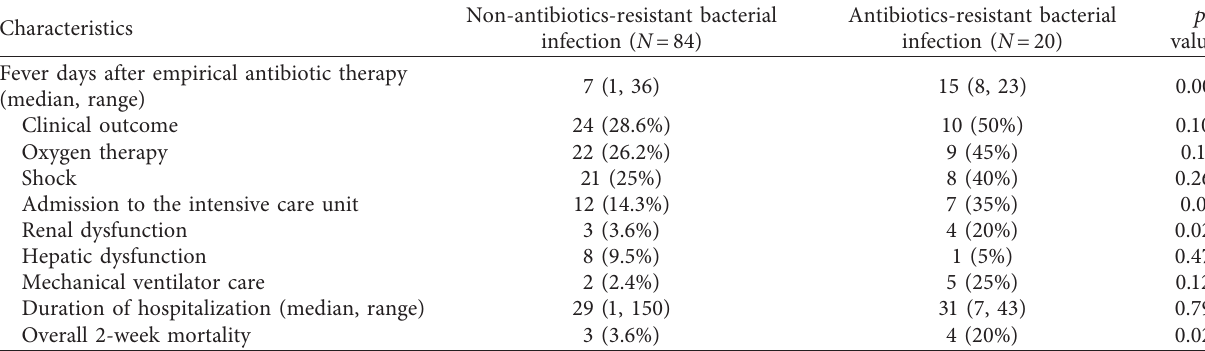
Table 7: Therapeutic response in febrile neutropenic children with Gram-negative bacterial